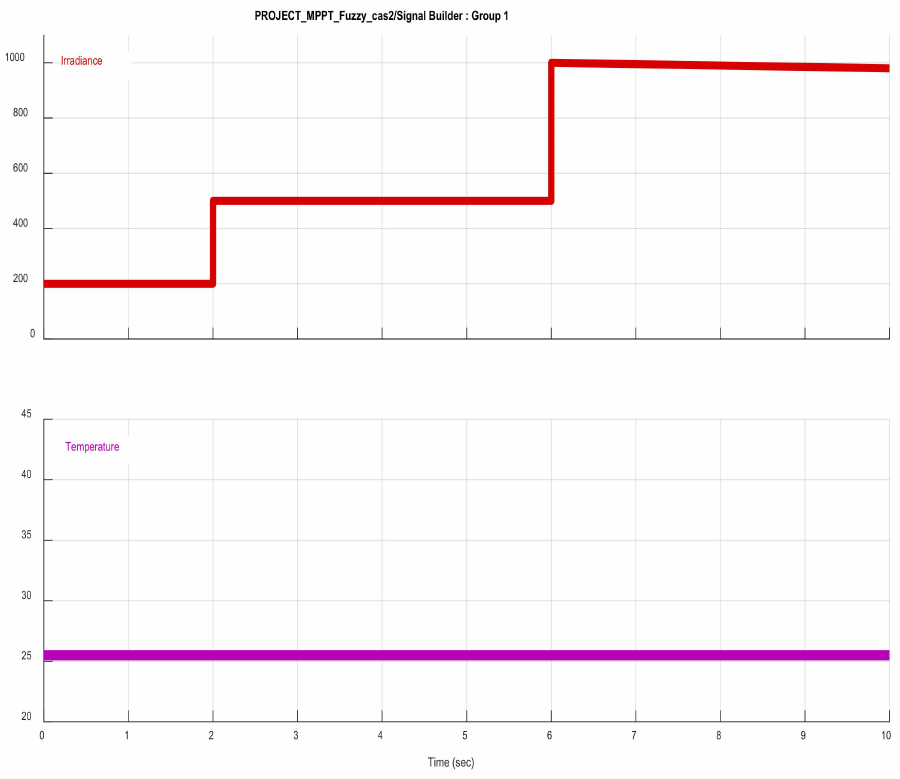
Figure 17. Variable irradiance response at 25 ◦